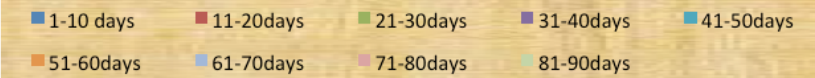
Figure 10. Colonization pattern of the 6 th group of